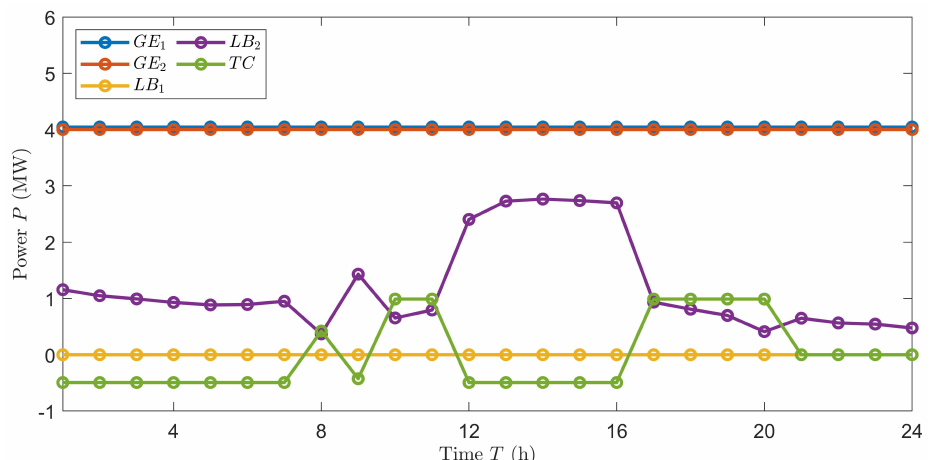
Figure 8. Equipment output (heating season, determining electricity by heat).